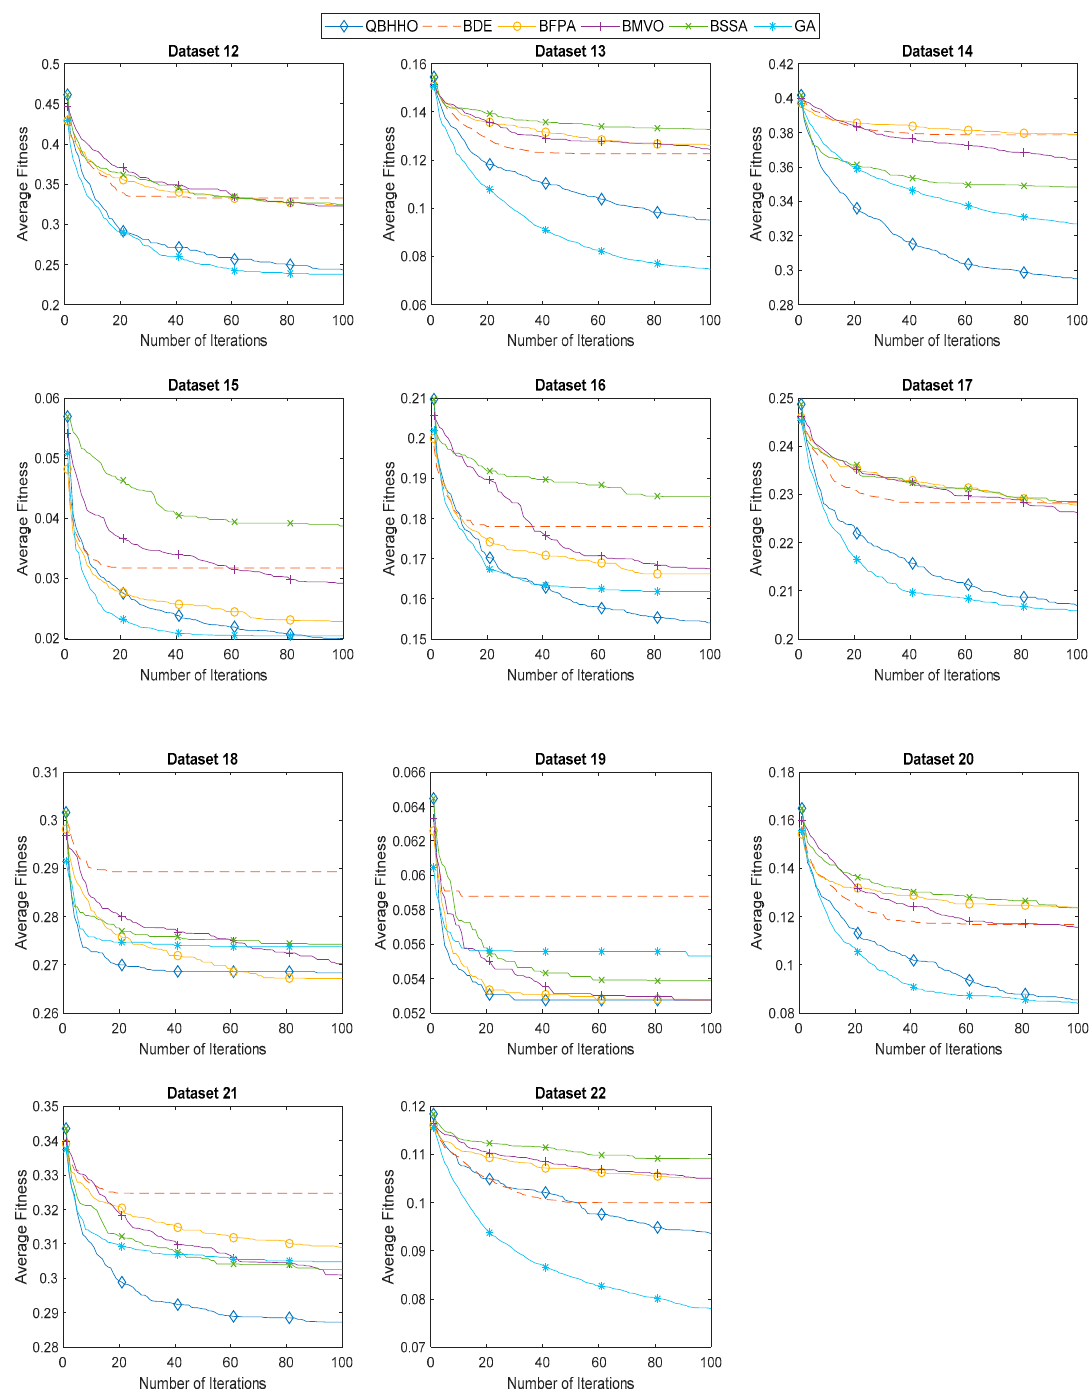
Figure 8. Convergence curves of six different algorithms on datasets 12–22.